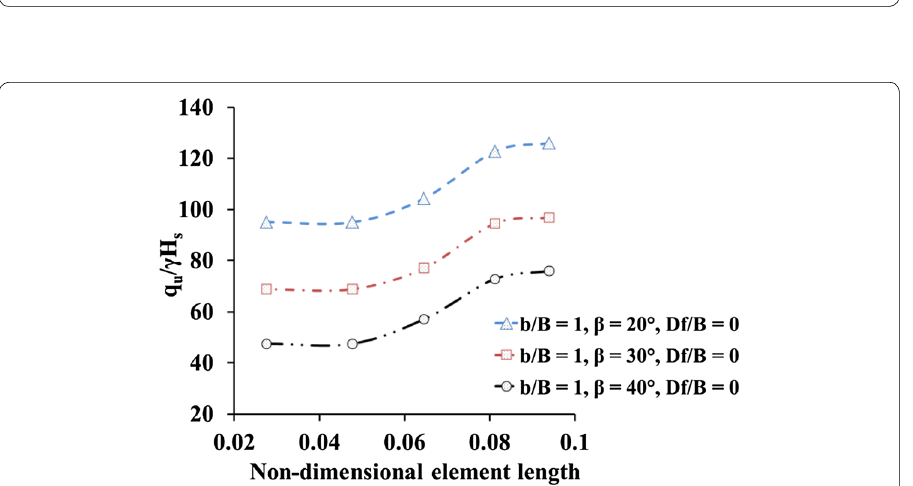
Fig. 8 Typical convergence study for footing resting on sloping